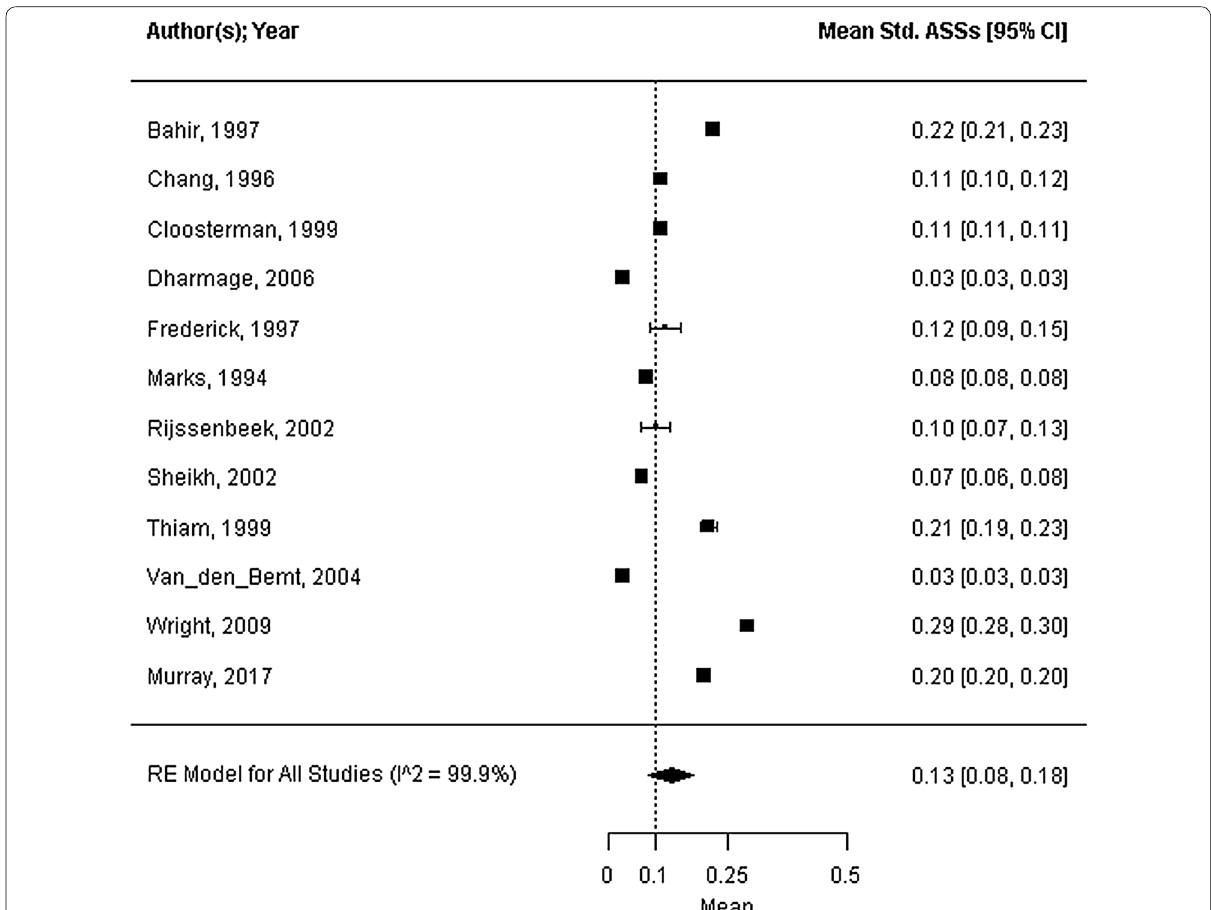
Fig. 3 Forest plot of the standardized asthma symptom scores at